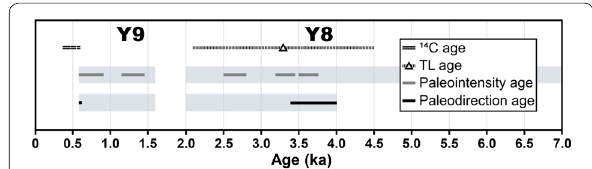
Fig. 7 Comparison of 14 C, TL, paleodirection, and paleointensity age results. 14 C ages are shown as years before AD 2000 (yrb2k) (2 σ ). Mean value of TL age (3.3 ka) is denoted by open triangles. Time ranges in which paleomagnetic datings were carried out were marked in